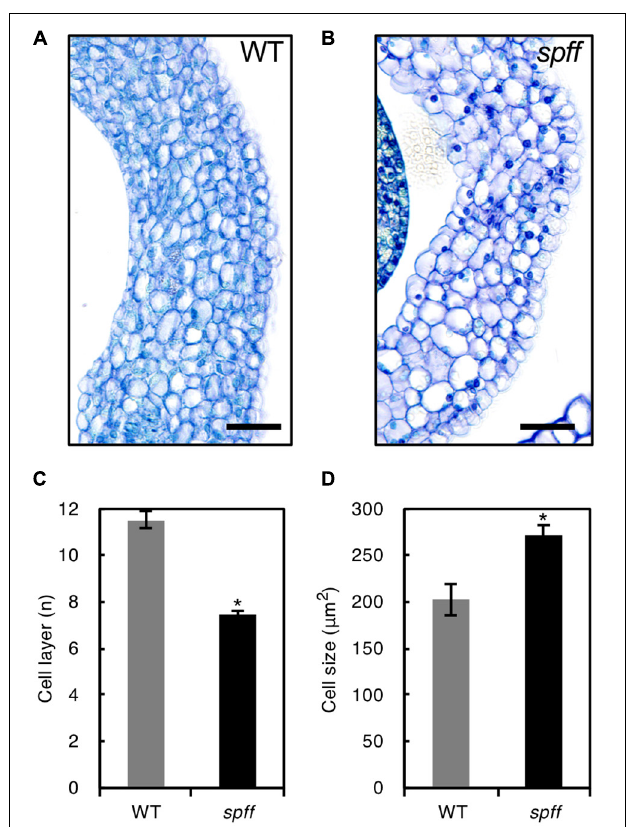
FIGURE 2 | Inflorescence and fruit phenotypes of the spff mutant. (A) Parthenocarpic ratio in spontaneously produced WT and spff fruit. Fruit morphologies in WT (B) and spff (C) . Quantification analyses focused on the fruit diameter (D) and fruit fresh weight (E) . Bars are 1 cm. At least three biological repetitions were performed and their mean values with SE are shown.